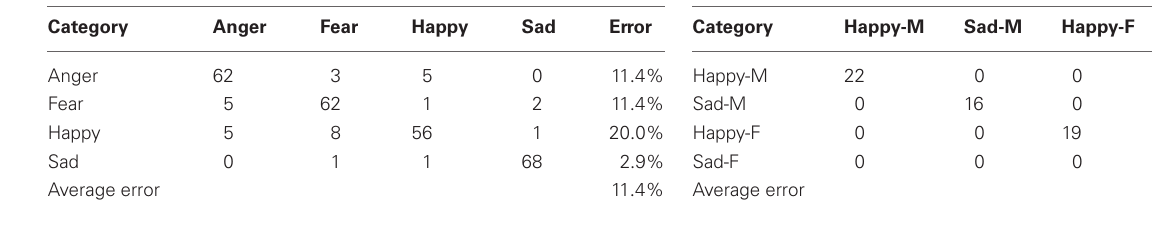
Table 1 | Human classification confusion matrix. Table 3 | Live Mode Recognition confusion